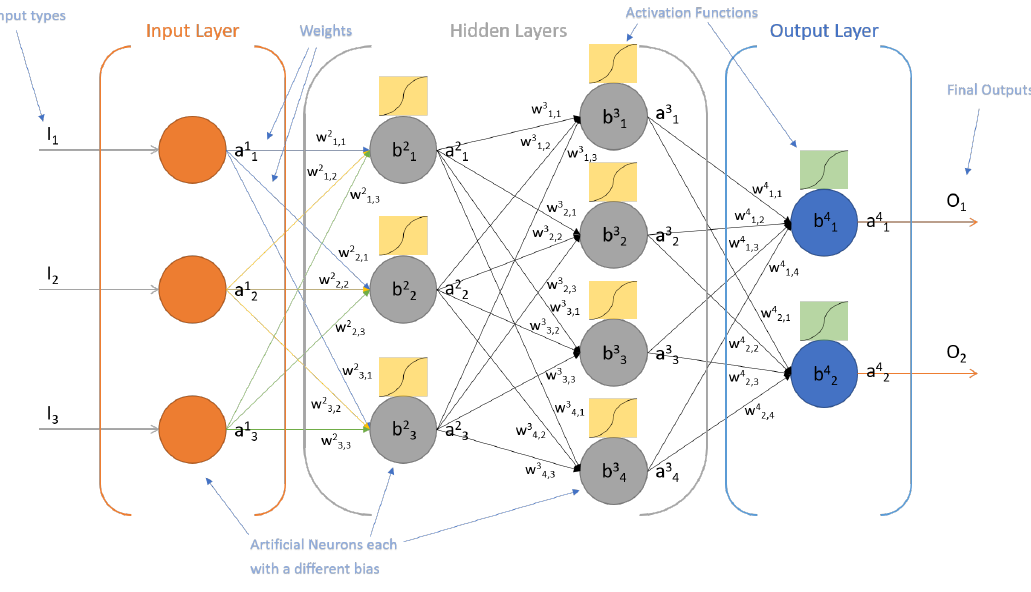
Figure 1. Visual Representation of an Artificial Neural